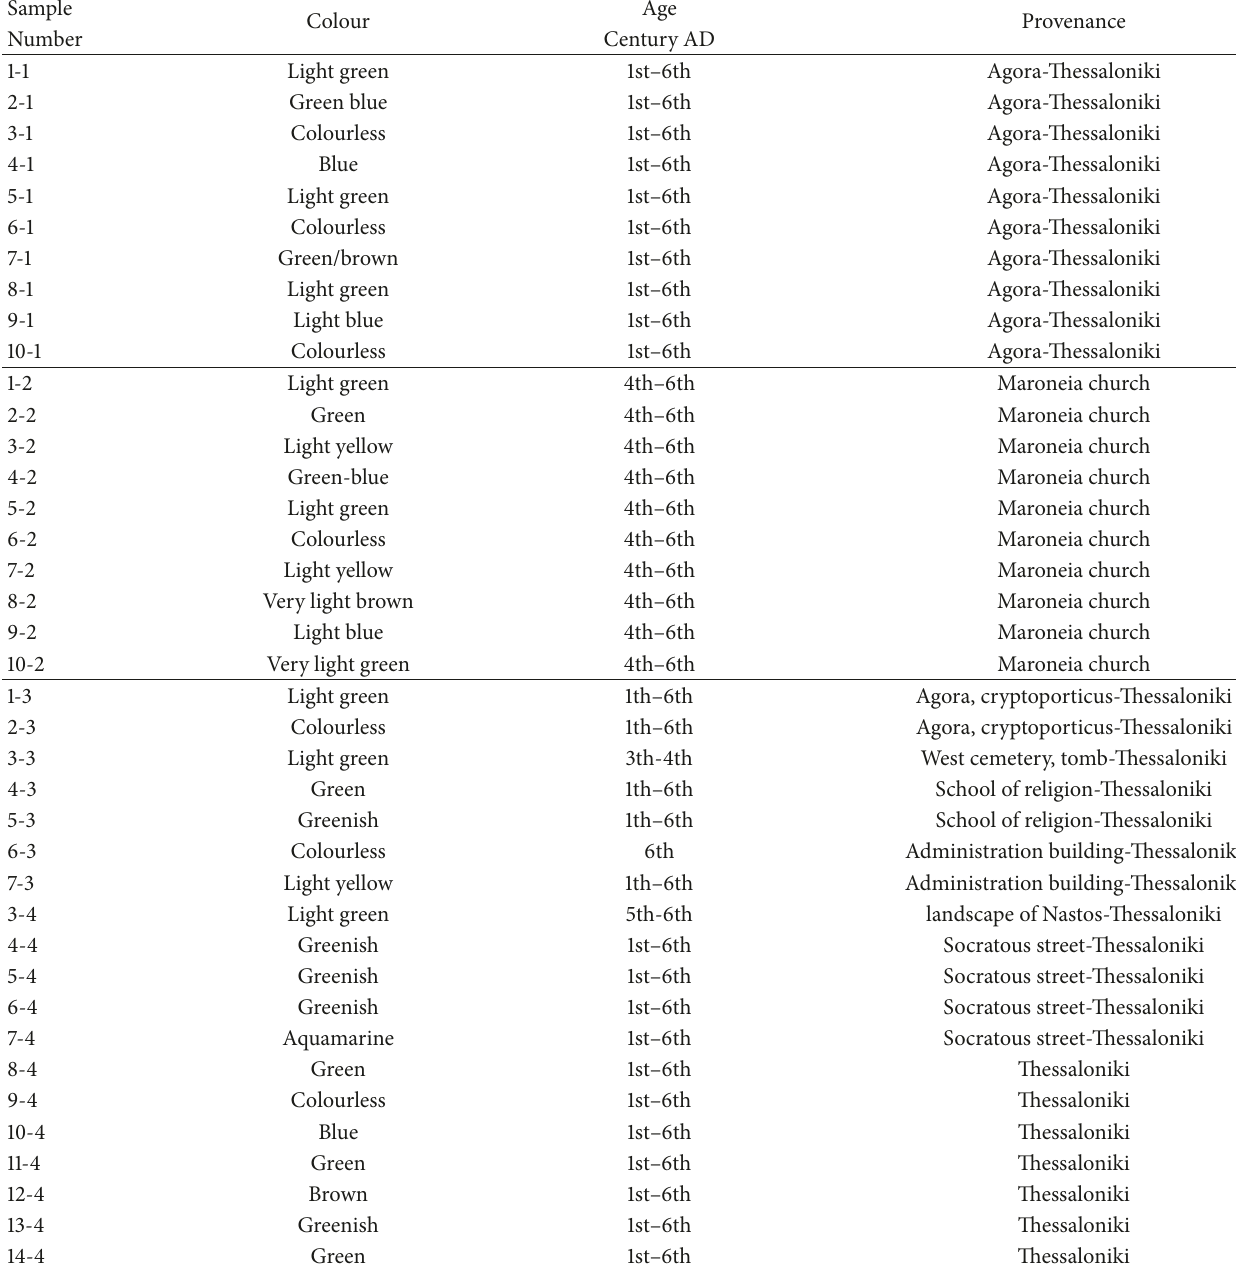
Table 1: List of analysed glasses from Greece. Colour, age and provenance also shown.